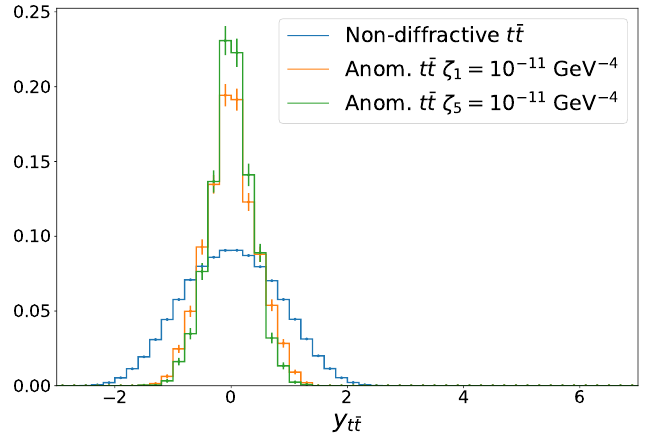
Figure 6. Rapidity distribution of the t ¯ t system as reconstructed from its decay products. Only events passing the pre-selection are shown. Histograms are normalized to